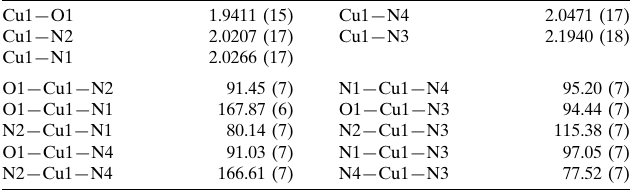
Selected geometric parameters (A˚ , (cid:2) ).